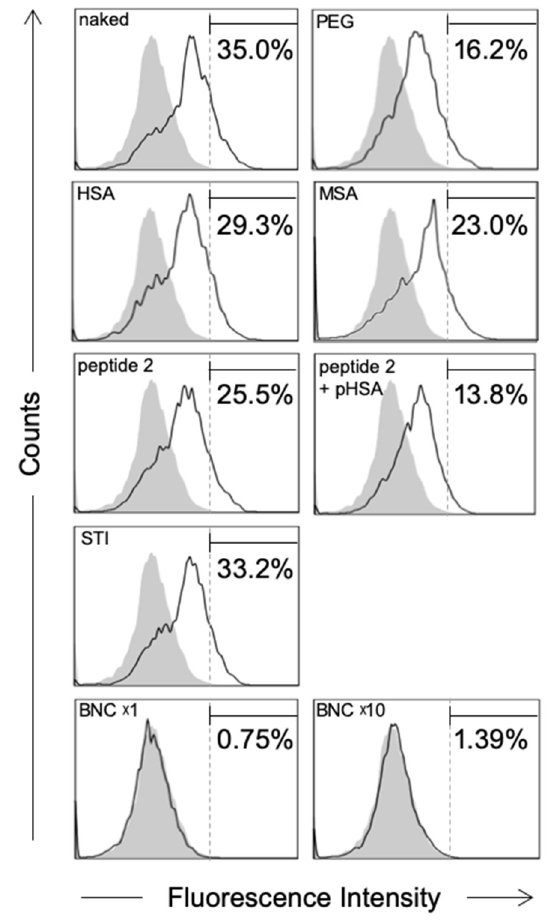
Figure 5. In vitro uptake of fluorophore-labeled microspheres and BNCs by Kupffer cells. After opsonization of Cy3-labeled BNCs and NYO-labeled microspheres (naked, PEG-modified, HSA-modified, MSA-modified, peptide 2-modified with/without pHSA treatment, or STI-modified), about 5 × 10 4 Kupffer cells were incubated with the NYO-labeled microspheres (about 5 × 10 8 particles) or Cy3-labeled BNCs (about 5 × 10 8 or 5 × 10 9 particles) at 37°C for 30 min and subjected to the FACS analysis. The fractions of Kupffer cells were predefined by the forward scatter/side scatter dot plots derived from CD11b + cells. Distributions of microspheres and BNCs in Kupffer cells were indicated as open histogram. Controls (untreated Kupffer cells) were indicated as shaded histograms. The percentages (%) of NYO-labeled or Cy3-labeled Kupffer cells were presented as numbers.